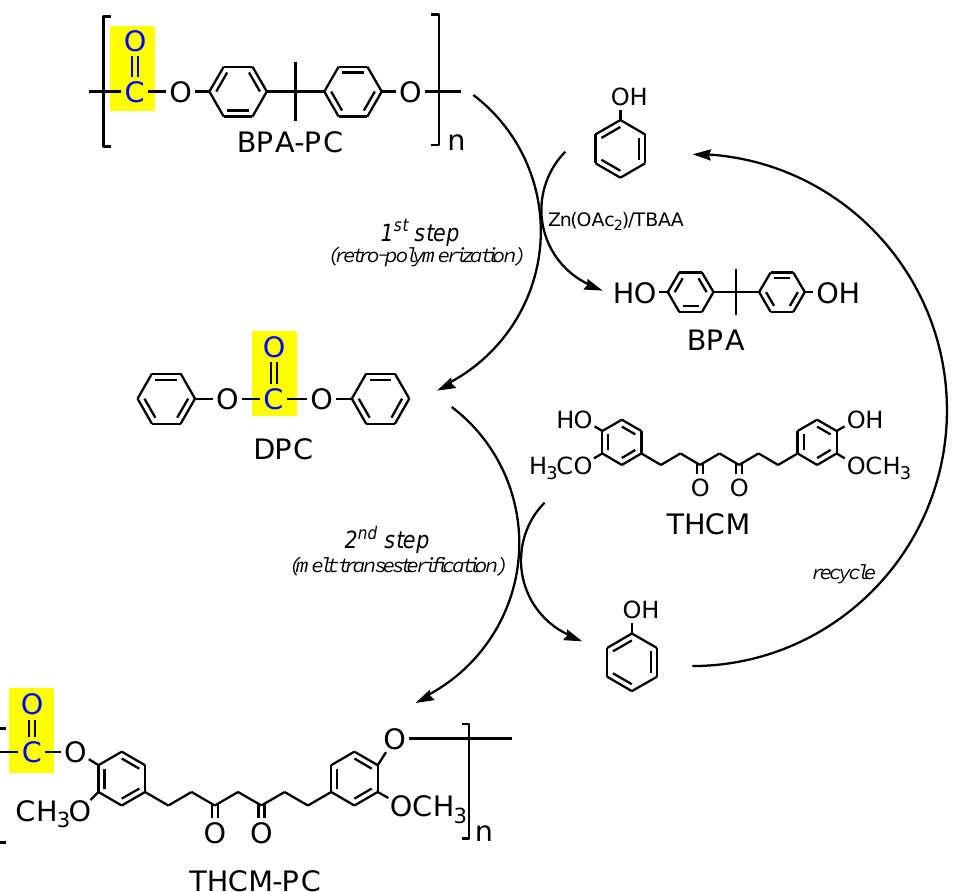
Figure 6. Scheme of trans-polymerization process for the synthesis of curcumin-based polycarbonates. For the preparation of CM-PC, CM is used instead of THCM in the trans-esterification.